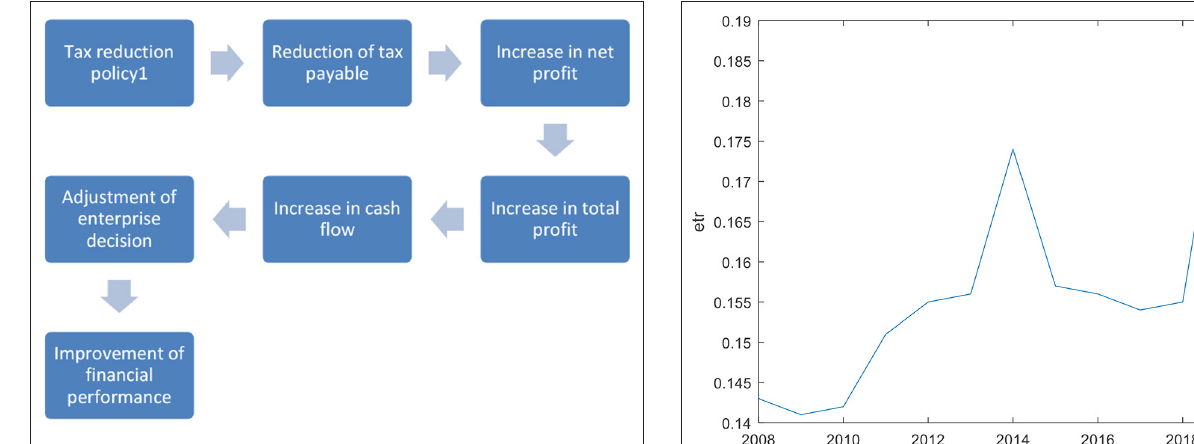
FIGURE 1 | Mechanism of tax reduction.